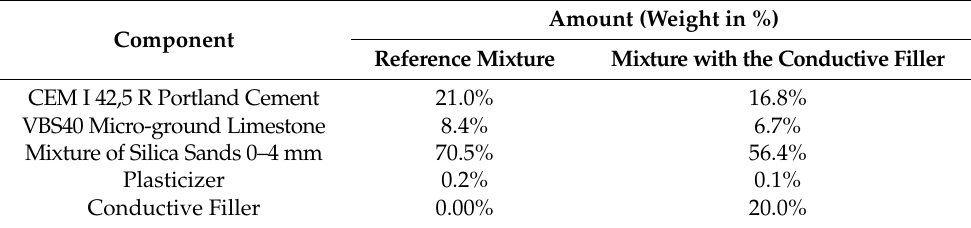
Table 8. Composition of the mixture for the verification of the resistivity of the